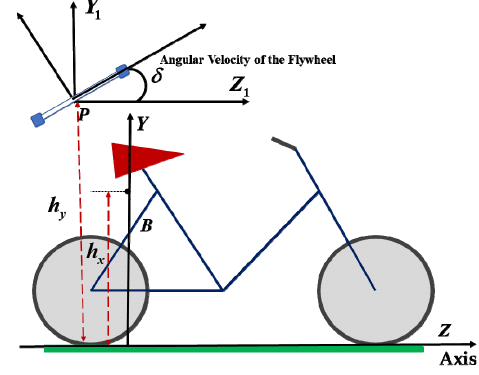
Figure 1. Reference Diagram of Bicyrobo (side view)